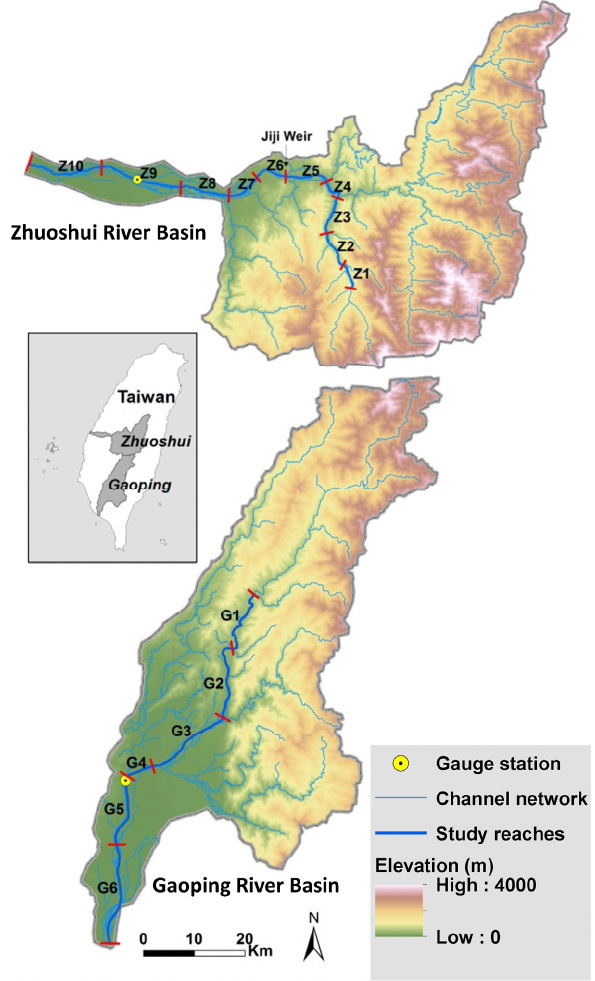
Figure 1. The location and terrain of the Zhuoshui and Gaoping River Basins. Study reaches are tagged (Z1~Z10 and G1~G6) and divided by red bars.